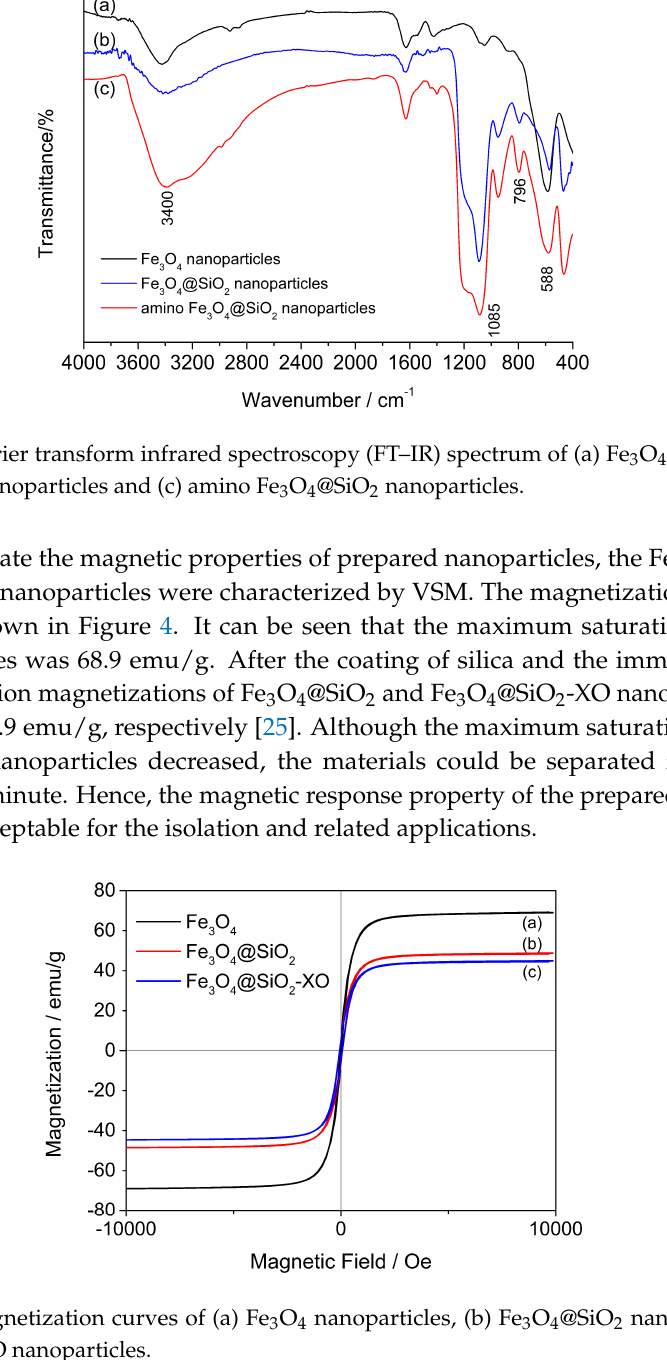
Figure 4. The magnetization curves of (a) Fe 3 O 4 nanoparticles, (b) Fe 3 O 4 @SiO 2 nanoparticles and (c) Fe 3 O 4 @SiO 2 -XO nanoparticles.